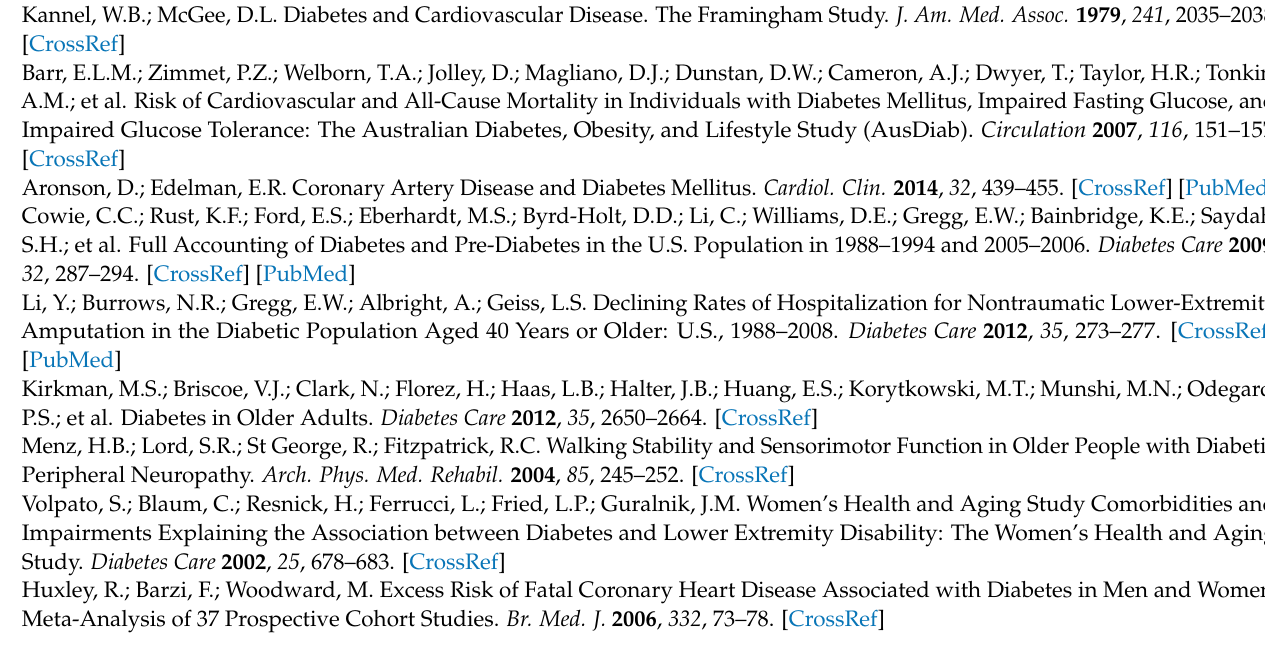
appendicular skeletal muscle mass, Table S2: Changes in anthropometric parameters and blood glucose at follow-up according to the diagnosis of IFG/T2D, Table S3: Changes in clinical